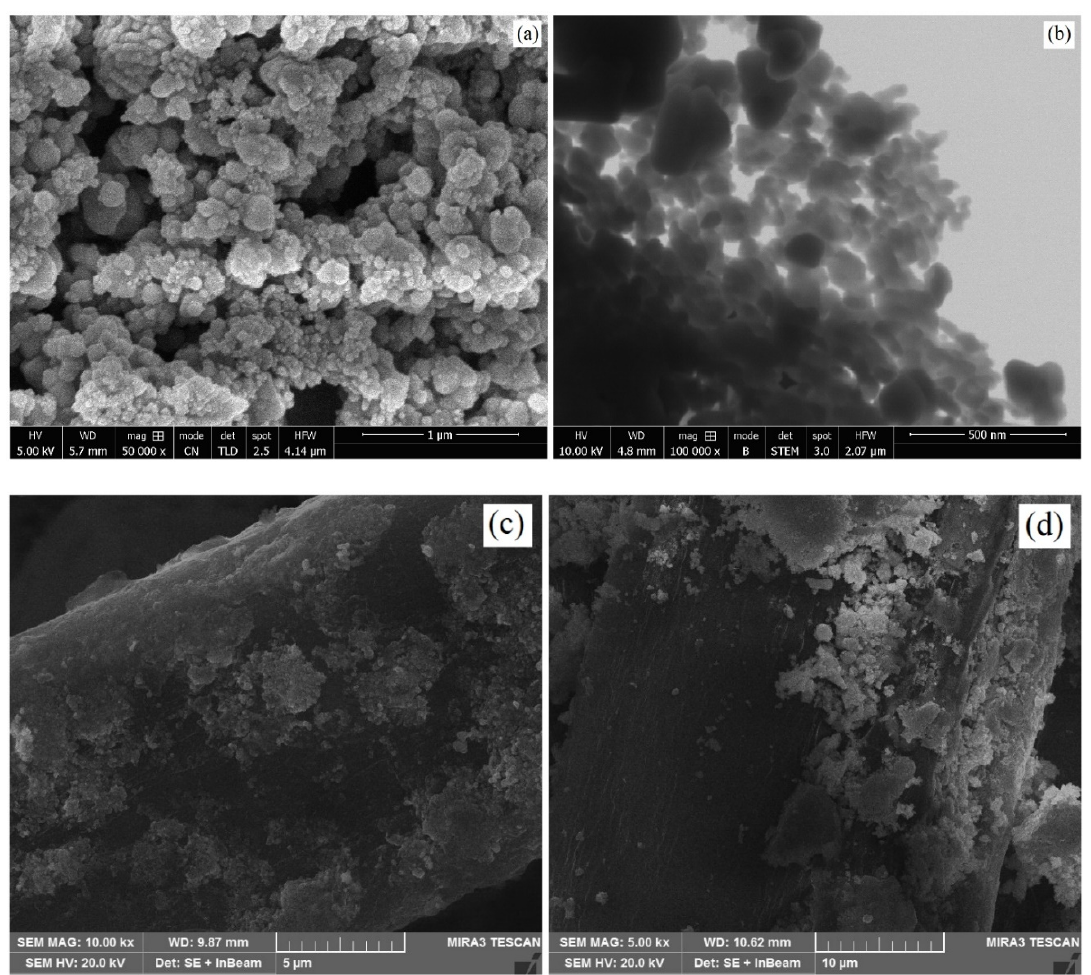
Figure 5. ( a ) SEM micrograph of as-produced ZnO, ( b ) STEM micrograph of as-produced ZnO, ( c ) SEM micrograph of ZnO-coated P1 sample and ( d ) SEM micrograph of ZnO-coated P2 sample.